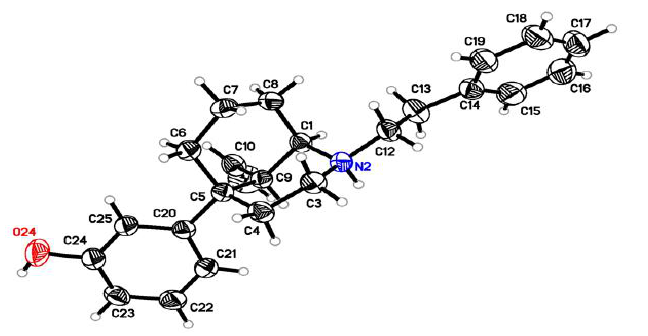
Figure 1. X-ray crystal structure of 8 (3-((1 R ,5 S ,9 R )-2-phenethyl-9-vinyl-2-azabicyclo [3.3.1] nonan- 5-yl) phenol). The ellipsoids are shown at the 50% probability level. Crystal data and atomic